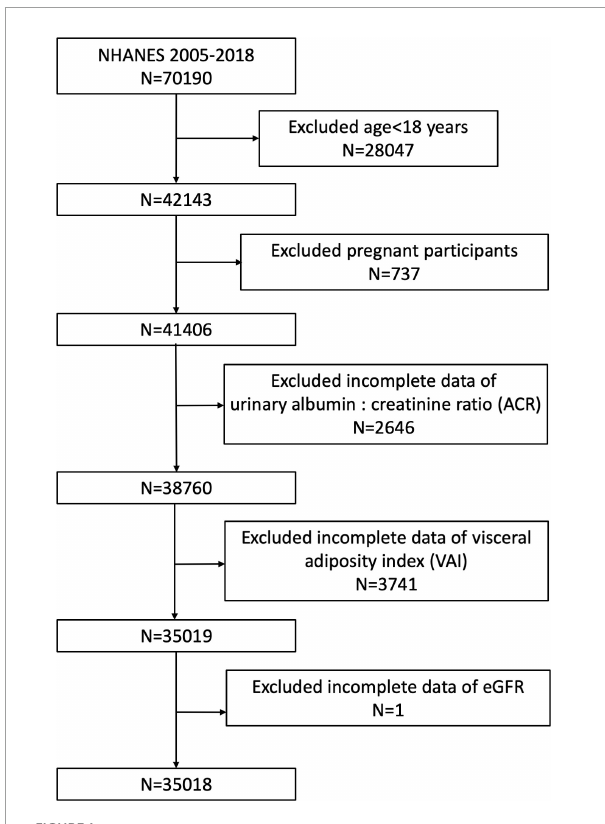
FIGURE1 Flowchart of the sample selection from NHANES 2005–2018.